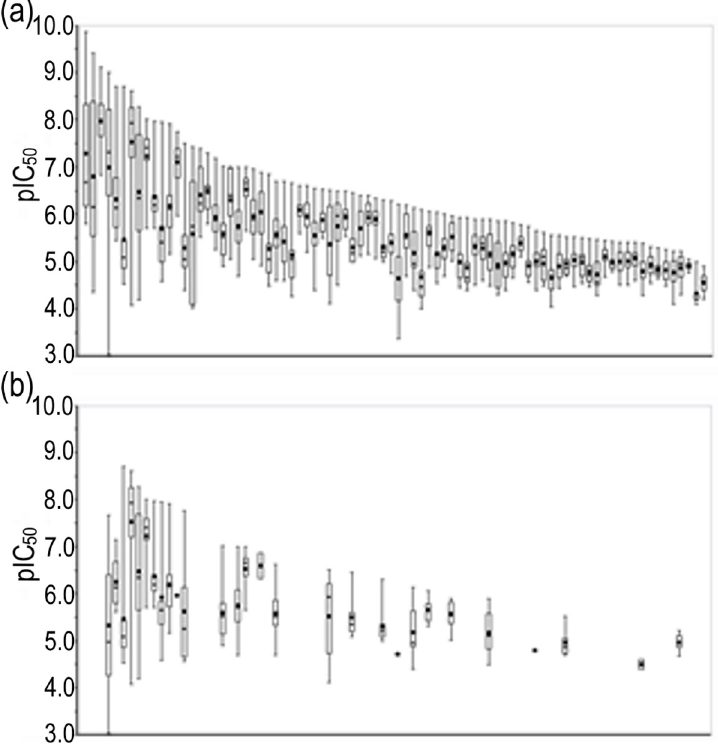
Fig 8. Box plot of IC 50 distribution about each Murcko framework. (a) IC 50 values for 82 Murcko frameworks containing more than 10 compounds sorted by the IC 50 values of the most potent inhibitors. (b) Corresponding IC 50 values reported before 2009. The horizontal axes of both plots represent each of the 82 Murcko